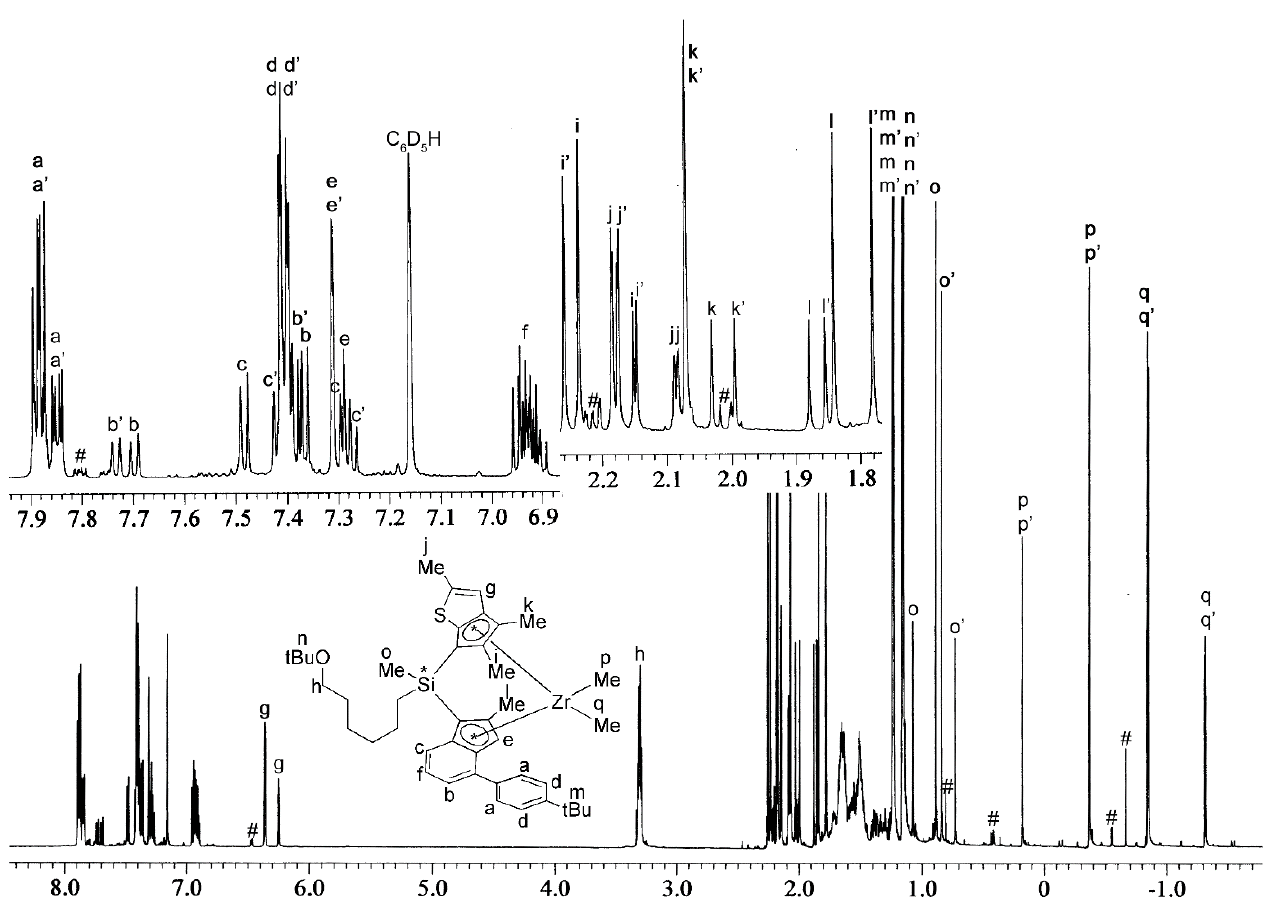
Figure 3. 1 H NMR spectrum of 23 . Racemic-type and meso-type complexes in 1:0.4 ratio (or vice versa) are further split in 1: 0.9 and 1: 1 ratios, respectively, which are assigned as o , o ′ , o, and o ′ , for example, for Si–CH 3 signals. Signals for unidentified impurities are marked with # and the chiral centers are marked with asterisks.